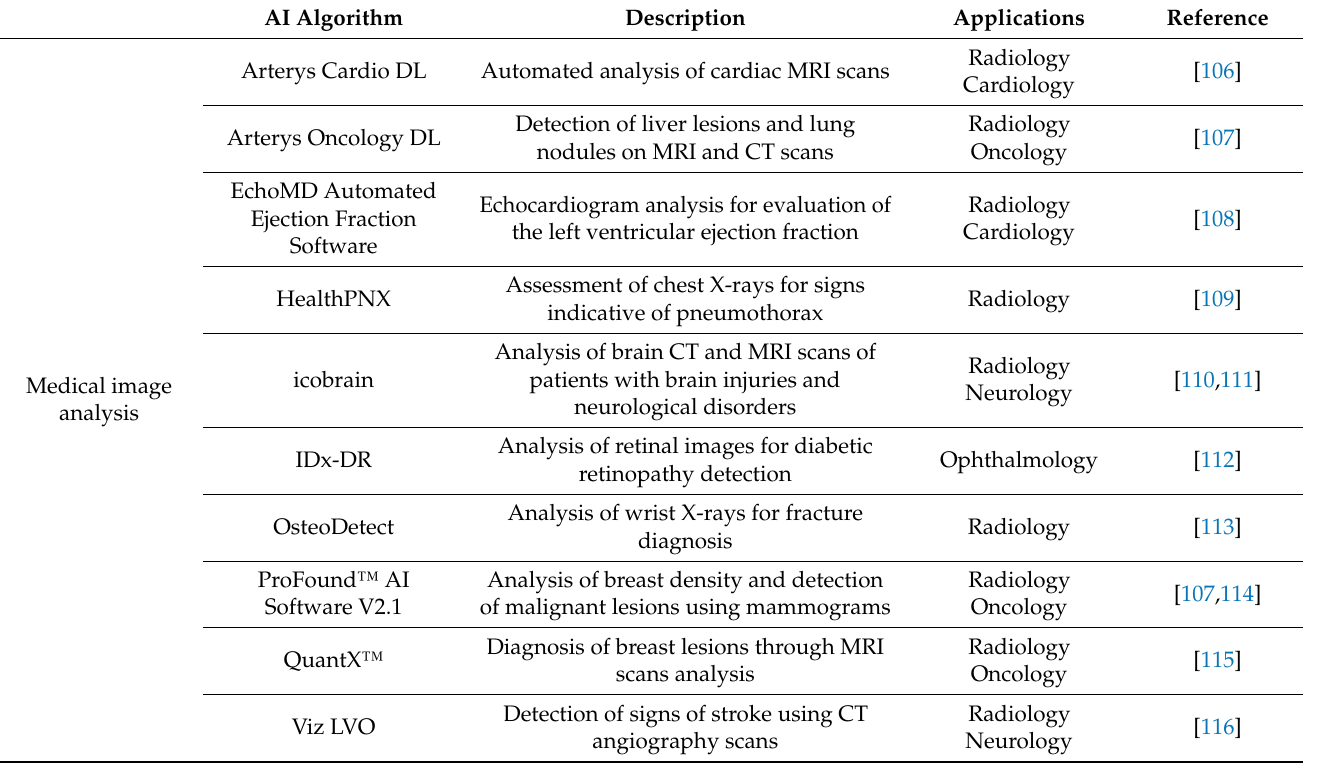
Table 2. Examples of U.S. Food & Drugs Administration (FDA)-approved AI applications in the field of